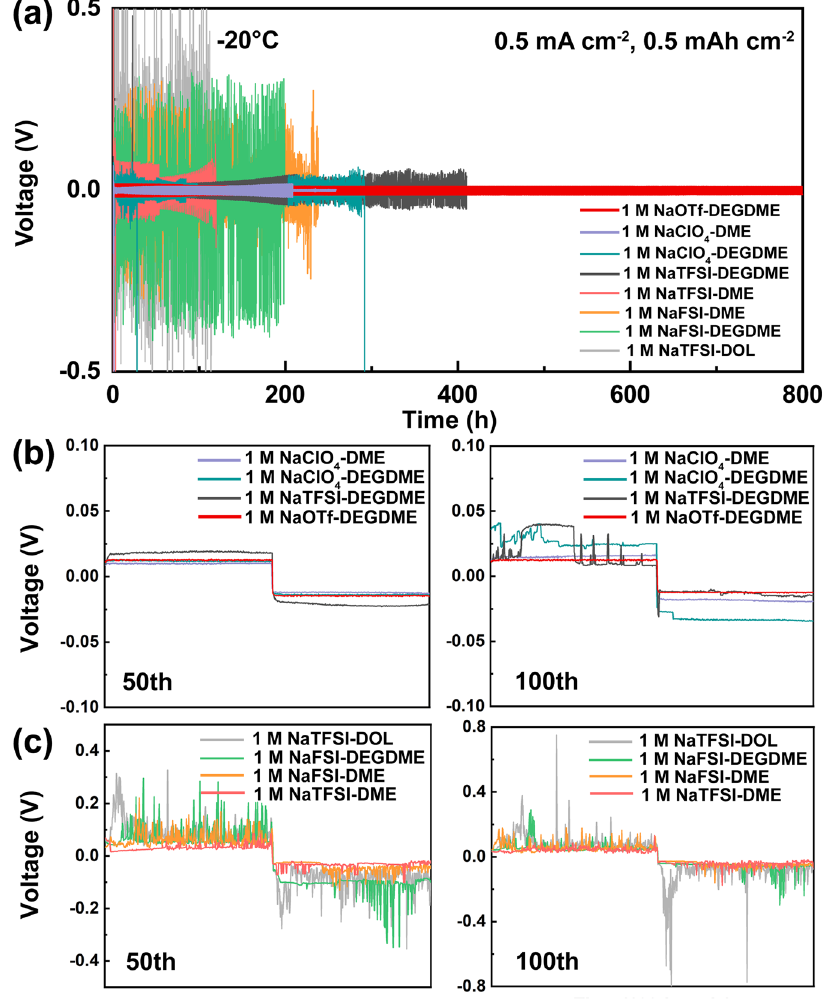
Fig. 1 | Electrochemical cycling of Na metal electrodes in various electrolyte formulations at − 20°C. a Galvanostatic cycling of Na||Na symmetric cells oper- ating in eight different electrolyte formulations with a 1M salt concentration at